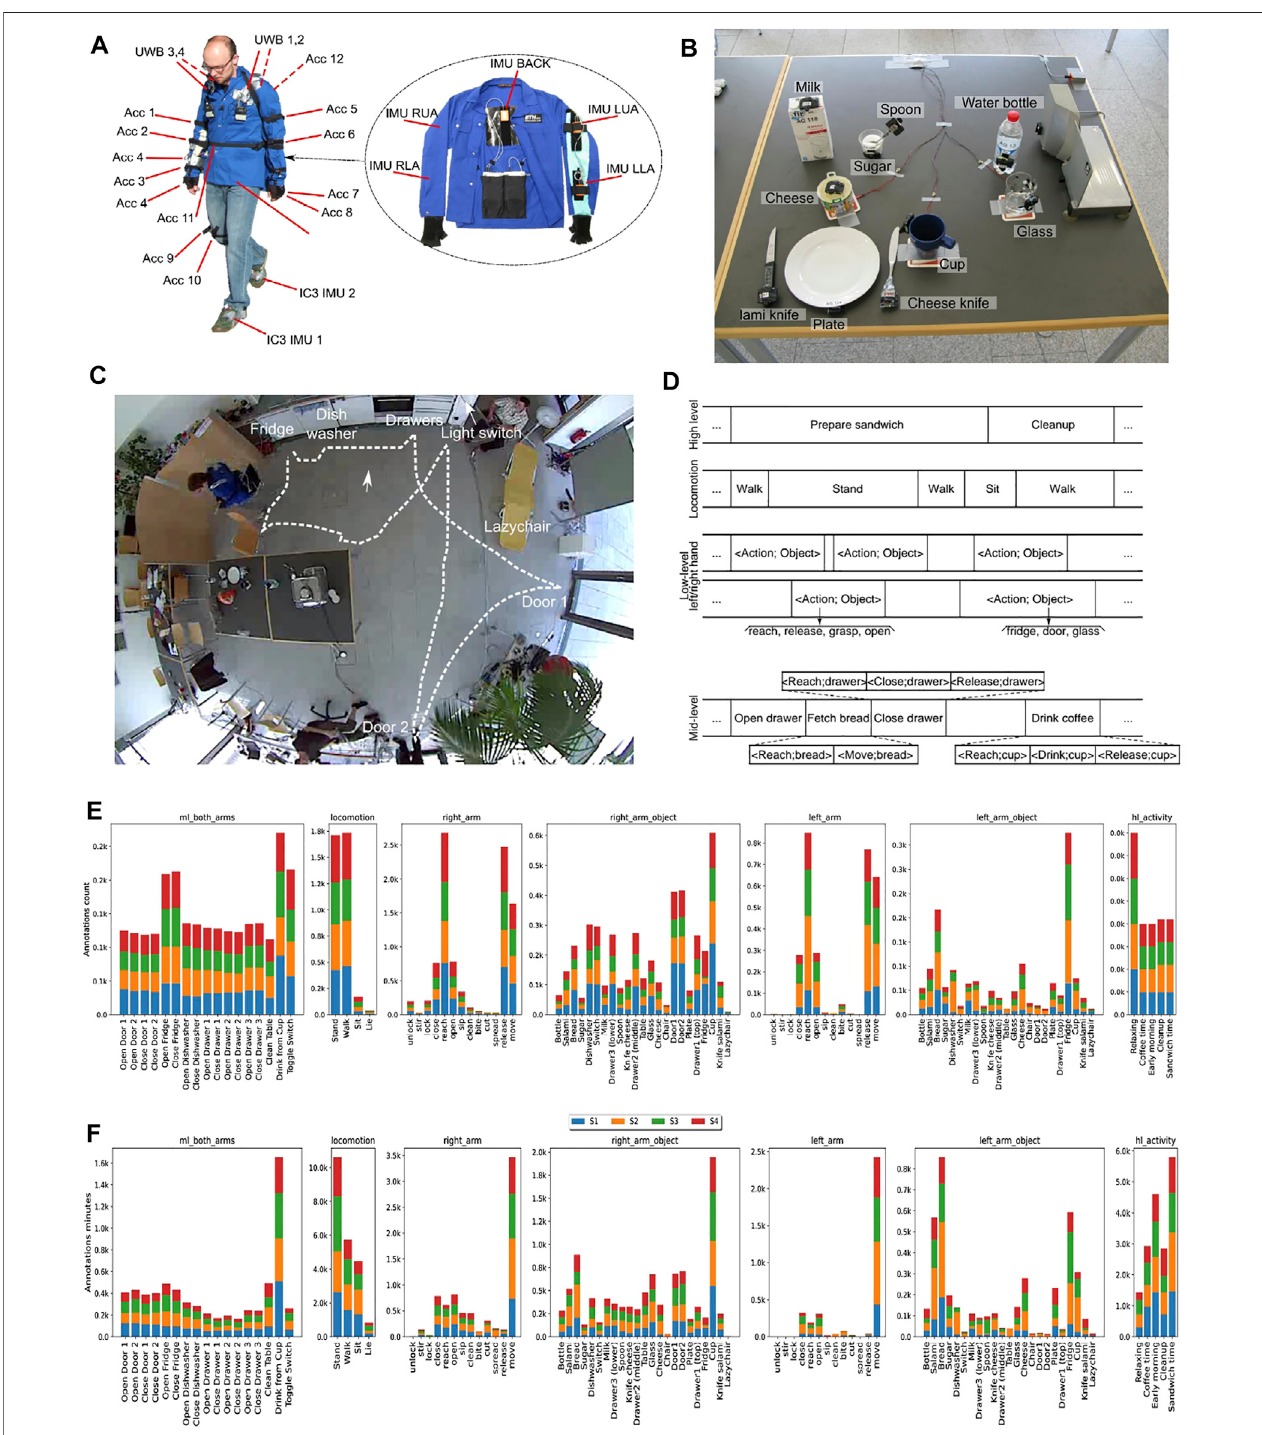
FIGURE 1 | (A): placement of on-body sensors. Acc are 3D accelerometers; UWB are ultra-wideband localization tags; IMU are inertial measurement units (InertiaCube3ontheshoeandXsensMT9inthejacketontheupperbody). (B): instrumentedobjects(exceptthebreadandsalami). (C): topviewoftheenvironmentwith key instrumented environmental objects. (D): annotation through independent tracks indicating the high-levelactivities, the modes oflocomotion, the left and right hand action primitives, and fi nally the “ mid-level ” activities. (E, F): annotation counts and total time for each annotation, spanned by each annotation type, per-user.